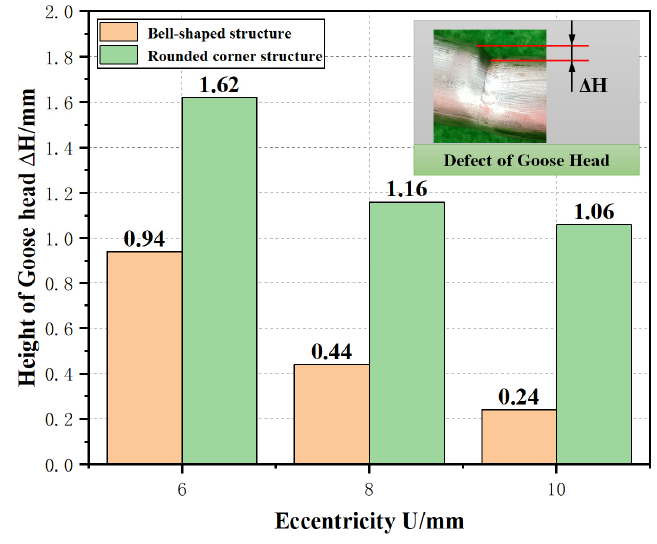
Figure 17. Goose-head height under different transition structures and eccentricities.